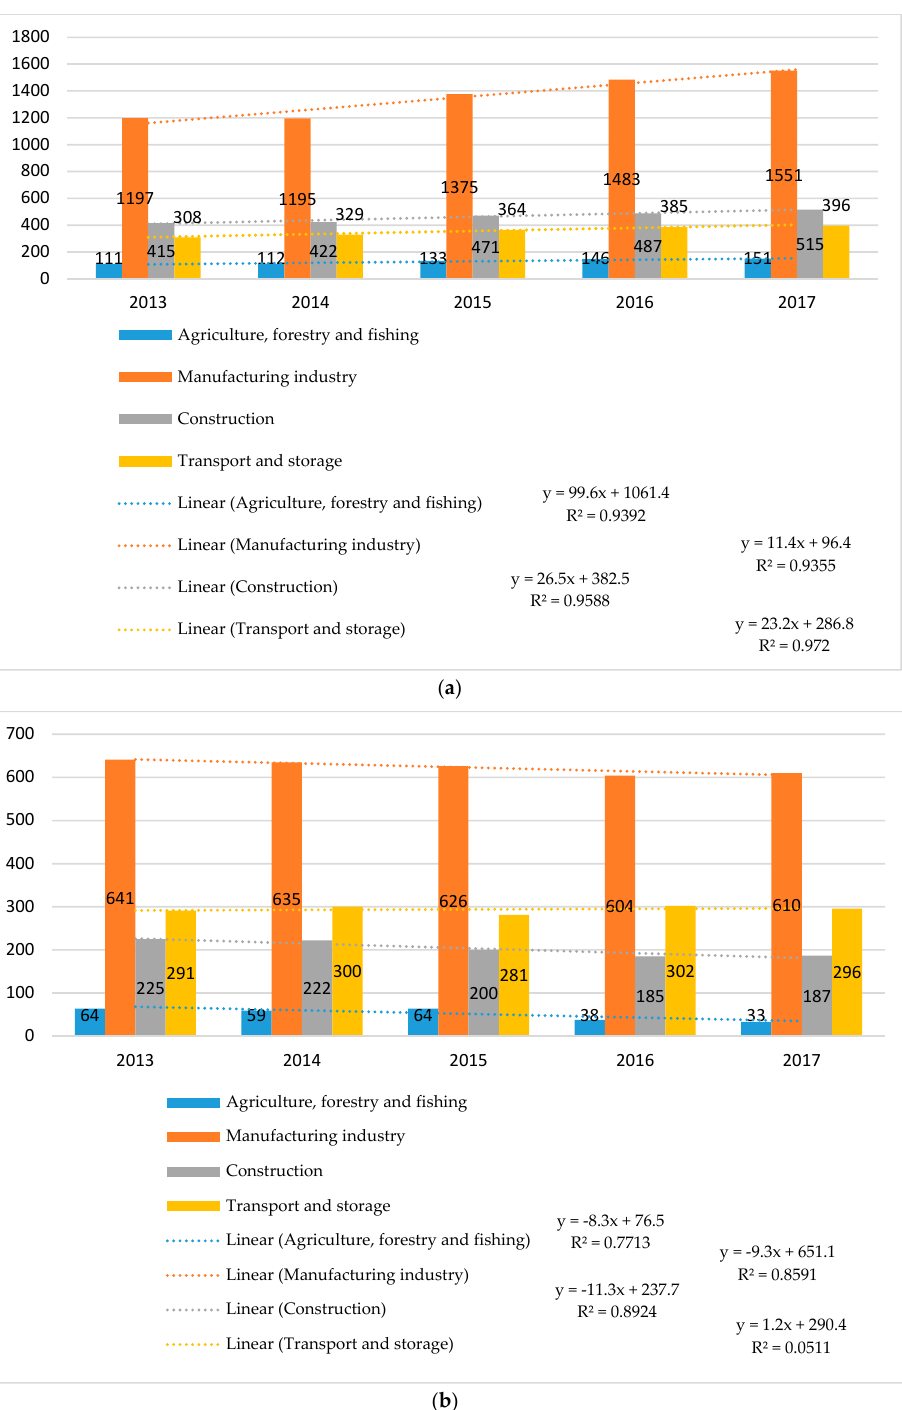
Figure 17. Situation of accidents in Romania ( a ) and Bulgaria ( b ) in the fields of: agriculture, forestry, and fishing; manufacturing industry; construction; and transport and storage in the period 2013–2017.